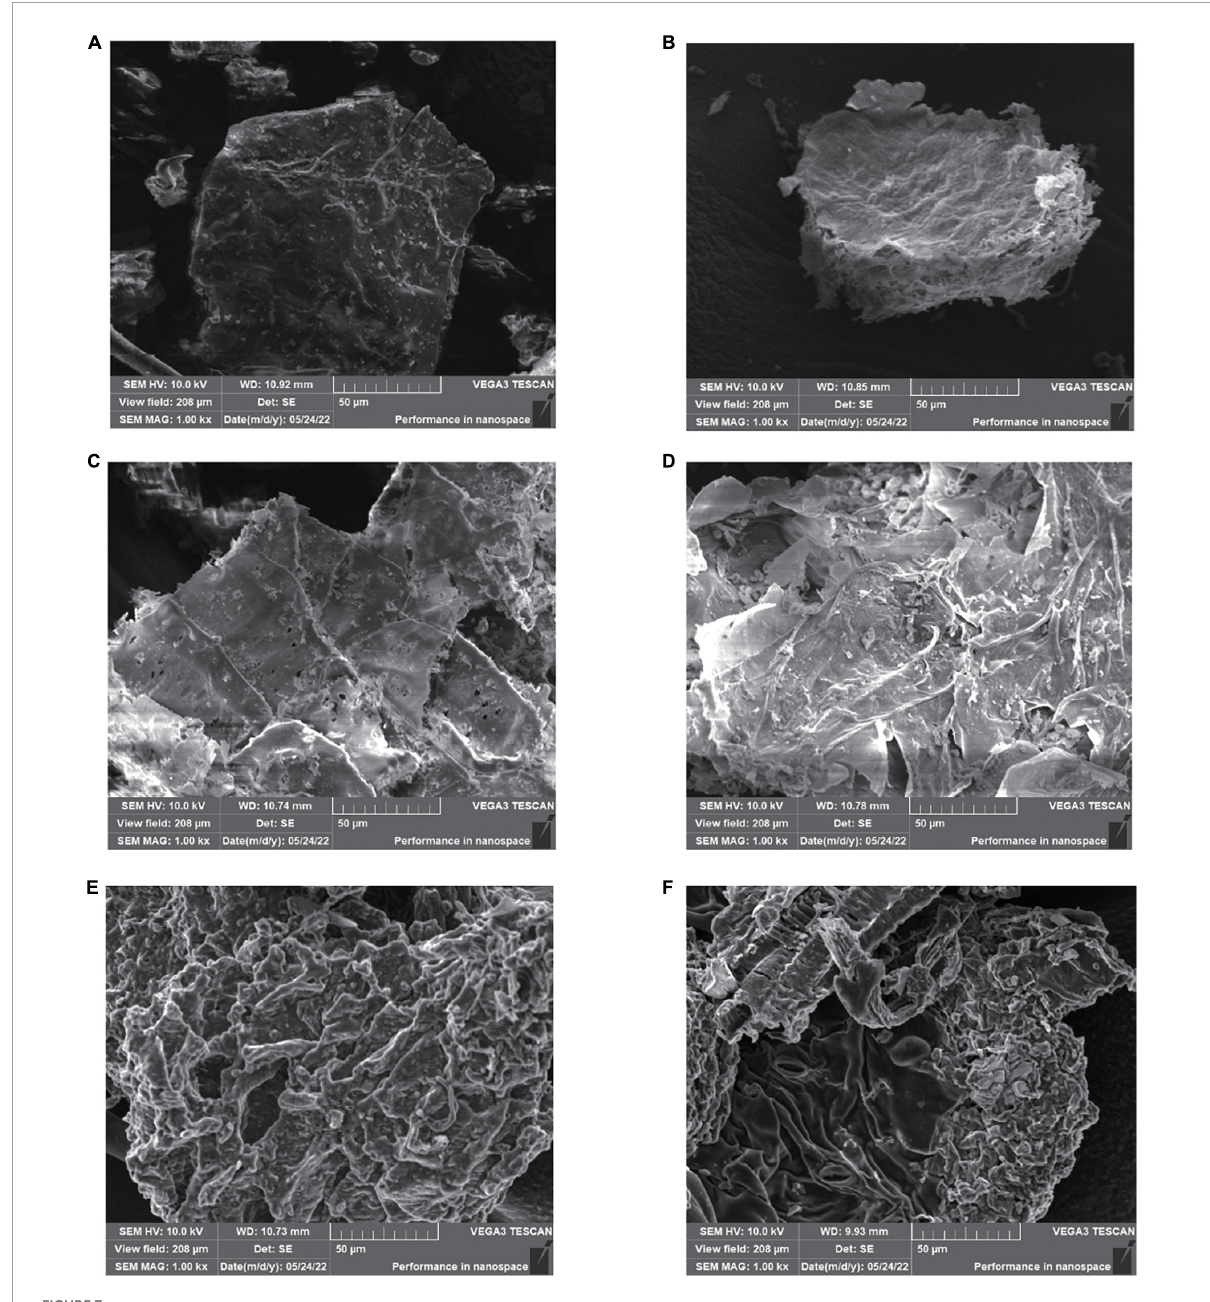
FIGURE7 Scanning electron microscopy (SEM) of Geum japonicum (GJ) original plant (A) , and after extraction with methanol-ultrasound assisted extraction (UAE) (B) , ethanol-UAE (C) , acetone-UAE (D) , choline chloride-oxalic acid (ChCl:Oa) bath extraction (E) , and choline chloride-oxalic acid-ultrasound assisted extraction (ChCl:Oa-UAE) (F)